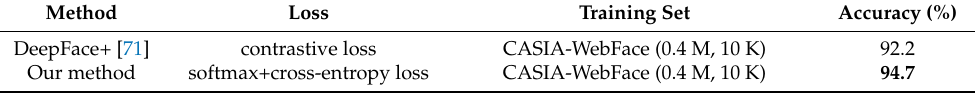
Table 15. Face recognition of different methods on the YTF dataset (using the same training dataset).